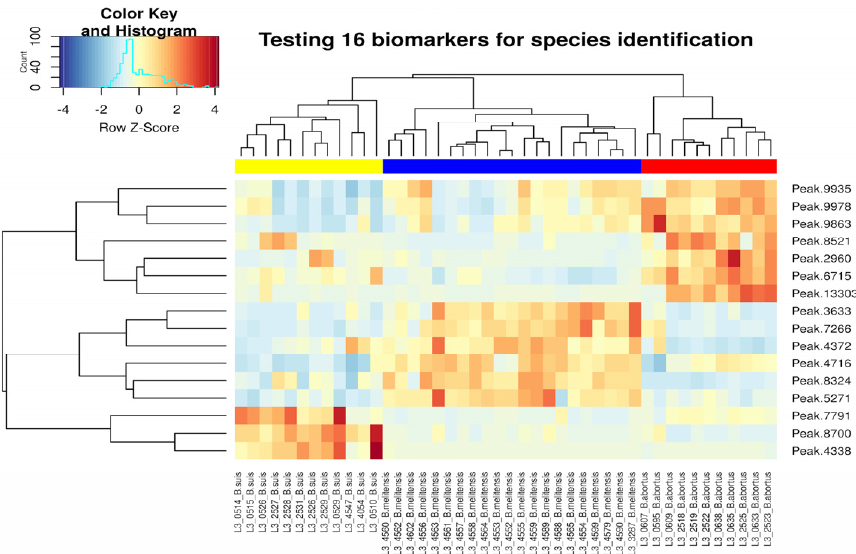
Figure 3. Heatmap displaying the intensities of the 16 potential biomarkers identified by means of a consensus feature selection method. Feature intensity was reported with the color code red for “high intensity peak” and blue for “low intensity peak”. Samples and features were ordered by means of agglomerative hierarchical clustering with average linkage and Manhattan distance.